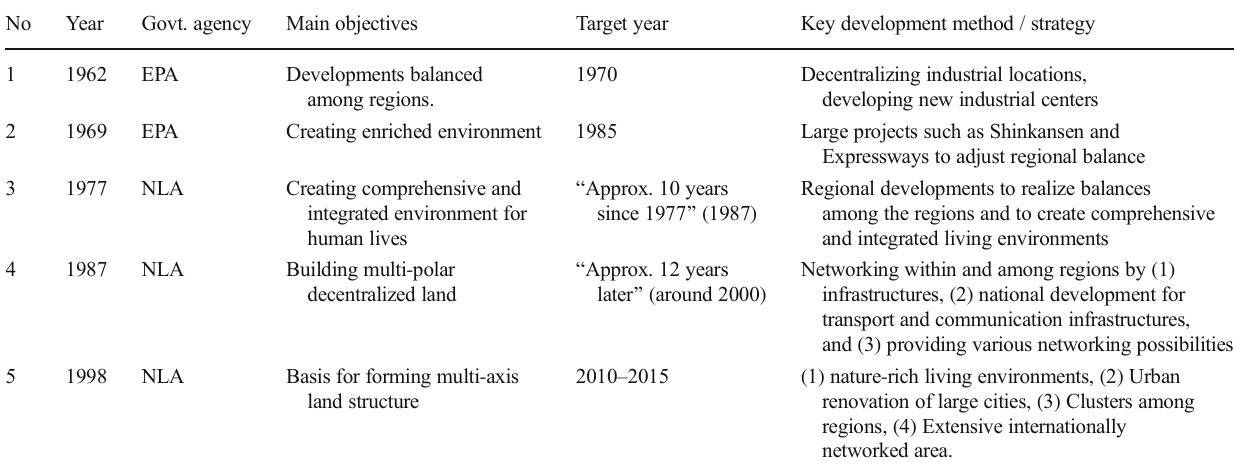
List and brief summaries of the Zensos, (Own translation based on